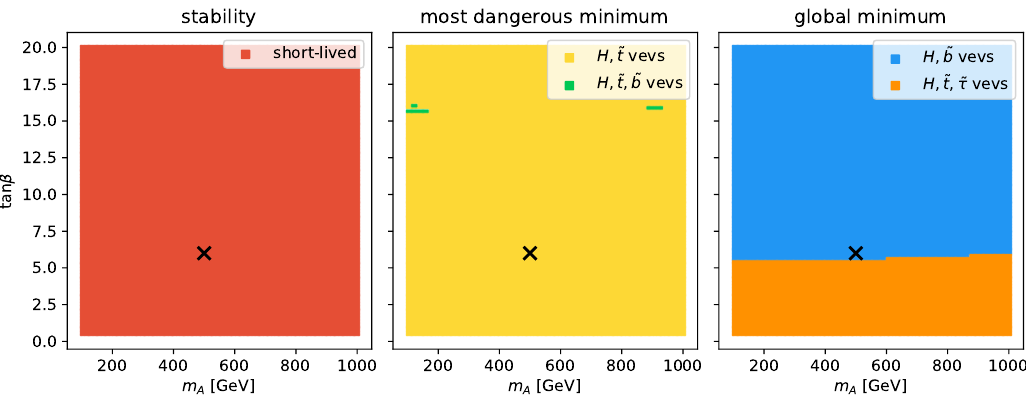
Figure 11 . Constraints from vacuum stability in the M 125 (alignment) scenario. The left panel h indicates the lifetime of the EW vacuum, which is short-lived all over the displayed plane. In the middle and right panel the character of the MDM and the global minimum is illustrated, respectively. The black (cid:2) indicates the same point shown in (cid:12)gure 9.